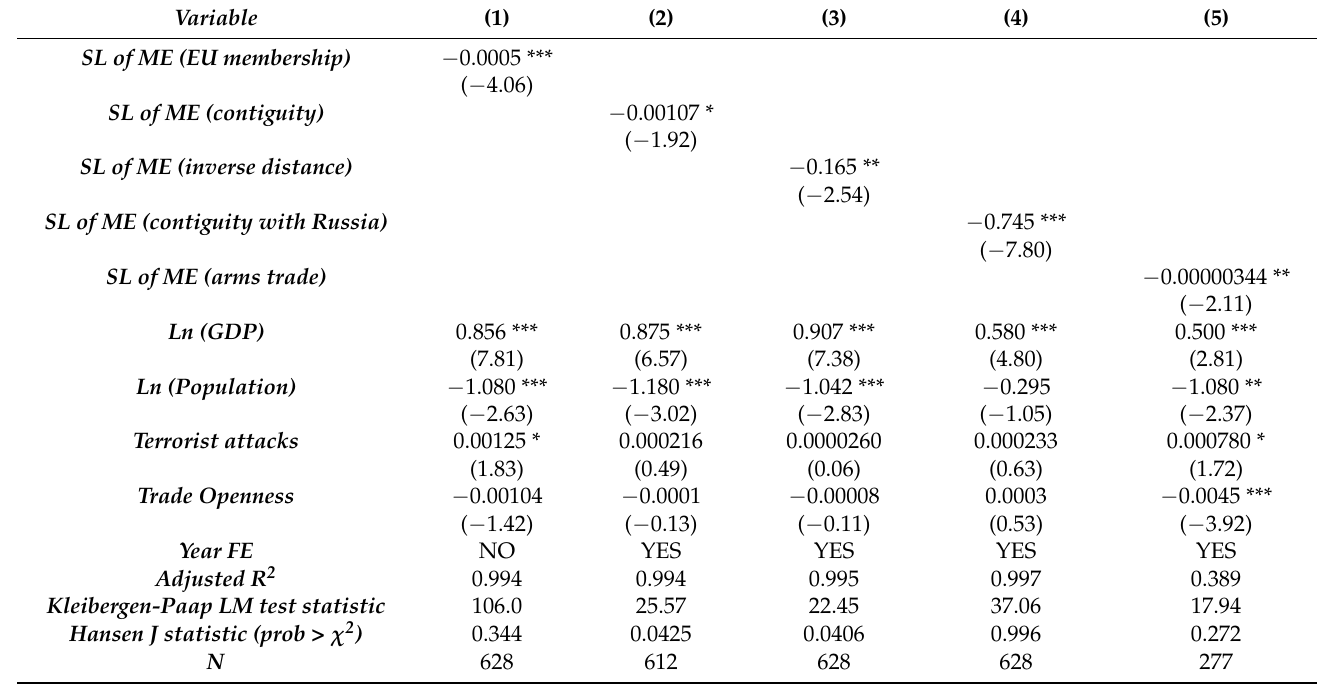
Table 1. EU military expenditure (ME), 1990–2019.